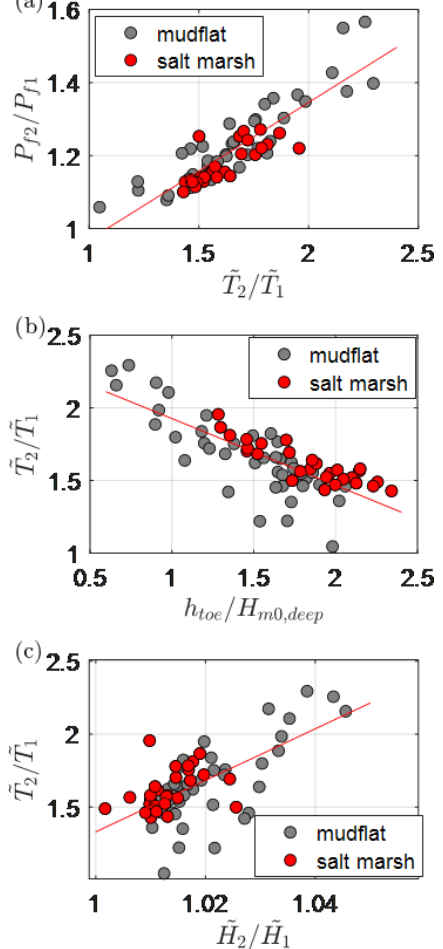
Figure 13. (a) Relationship between the change in probability of /P f failure due to IG waves ( P f ) and the increase in the relative 2 1 spectral wave period at the toe ( ˜ T 2 / ˜ T 1 ) with the relationship be- tween ˜ T 2 / ˜ T 1 and (b) the relative water depth ( h toe /H m ) and 0 , deep (c) the relative wave height at the toe ( H 2 / ˜ H 1 ), across the wider Wadden area. Note that ˜ T is a stand-in for T m − 1 , 0 , toe /T m − 1 , 0 , deep . Subscripts 1 and 2 refer to Scenario 1 and Scenario 2,